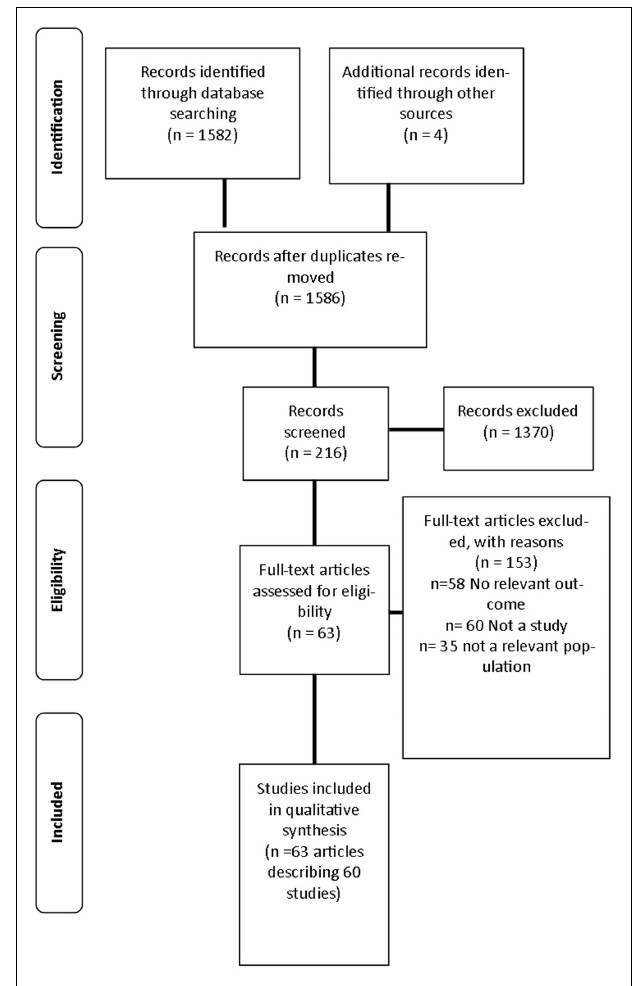
FIGURE 1 | Flow diagram of studies included in the review